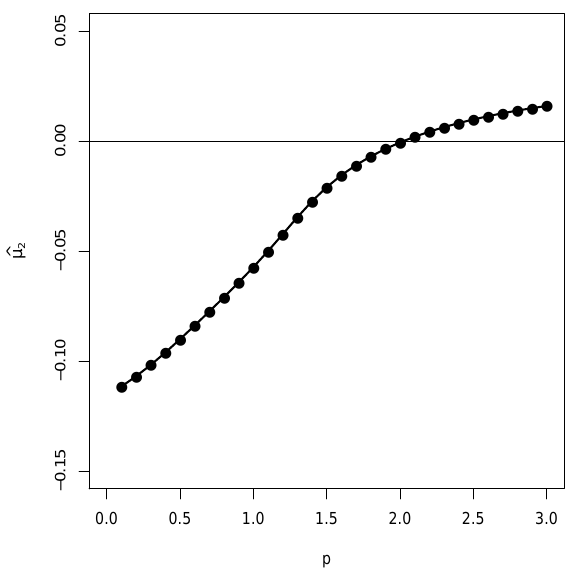
Figure 2. Estimated linking constant ˆ µ 2 as a function of power p